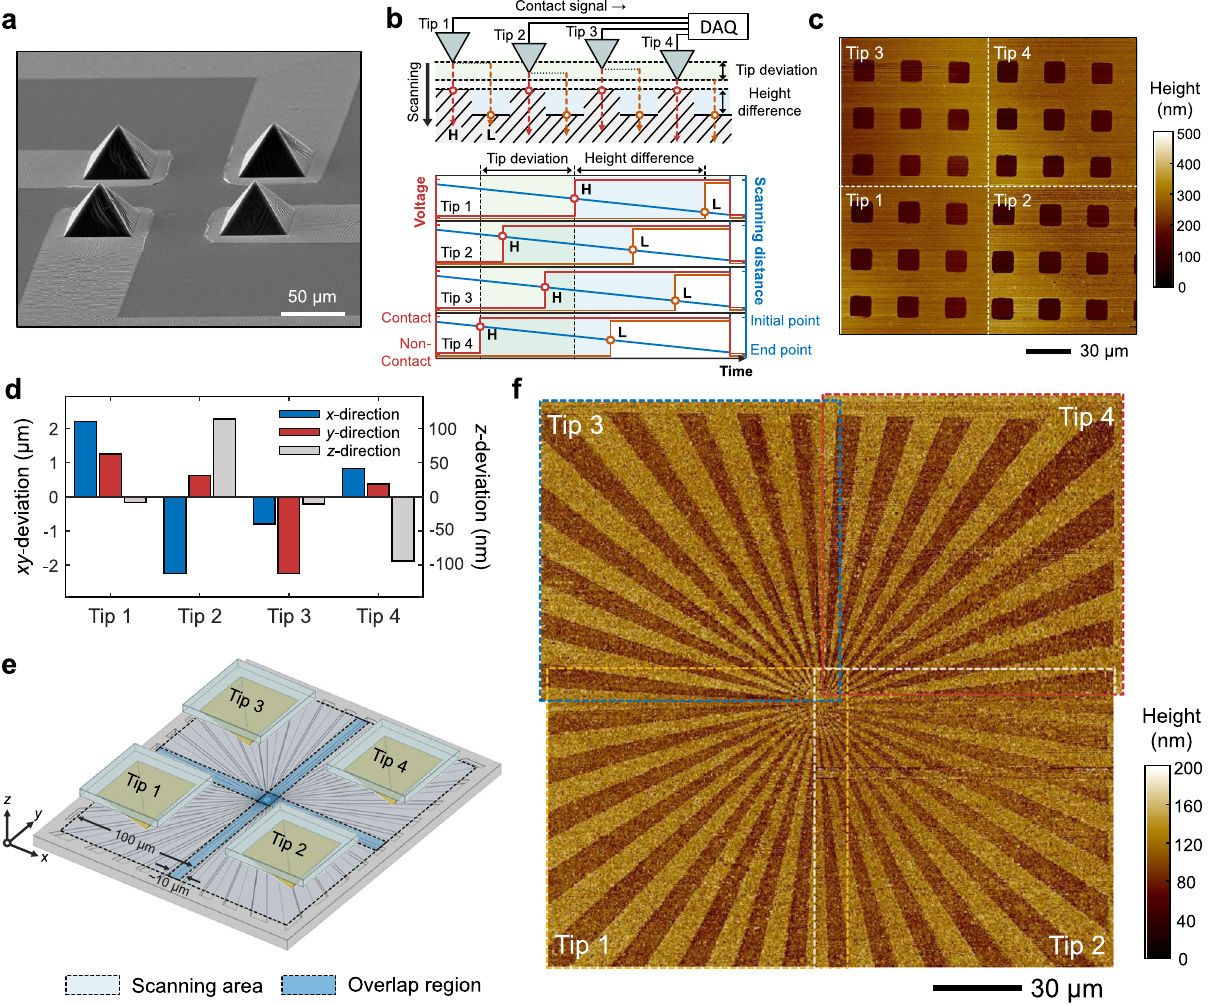
Fig. 4 Parallelization of BSPM. a SEM image of the 2 × 2 metal-coated elastomer tip array. b Schematic illustration and graphs depicting the parallelized measurement using a multiple probe array. c Topography images of the square patterns with a thickness of 138 nm obtained through parallelized measurement using the 2 × 2 tip array. d Deviation of the 2 × 2 tip array. xy - and z -deviations indicate the deviation in the position and the height of the tip, respectively. e Schematic illustration of parallel imaging with the overlapped scanning area. f Parallelized BSPM measurement of the Siemens star test chart using the 2 × 2 tip